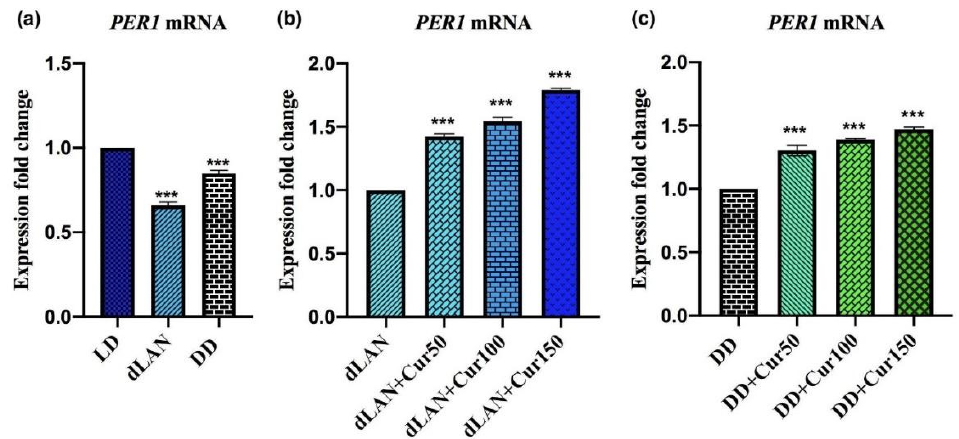
Figure 5. Effect of different concentrations (50, 100, and 150 mg/kg) of orally administered curcumin on the expression fold change of clock gene PER1 in dim light at night (dLAN) and complete darkness (DD)-exposed mice. ( a ) Light/Dark (LD) control vs. dLAN and DD, ( b ) dLAN control vs. dLAN treatment, and ( c ) DD control vs. DD treatment. Values are represented as mean ± standard deviation ( n = 5). One-way ANOVA with post-hoc Dunnett’s test was employed to match the results among the different treatment groups in different lighting conditions. All the data were analyzed with GraphPad Prism software. The statistical value *** p < 0.001 represent a significant difference among the groups.